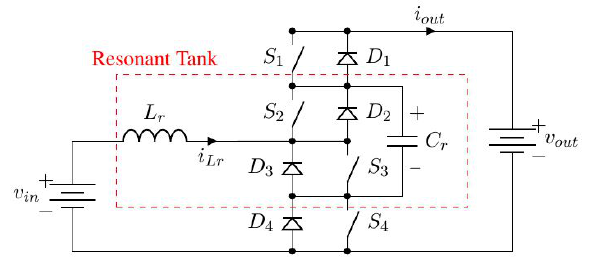
Figure 7. Resonant buck-boost converter.